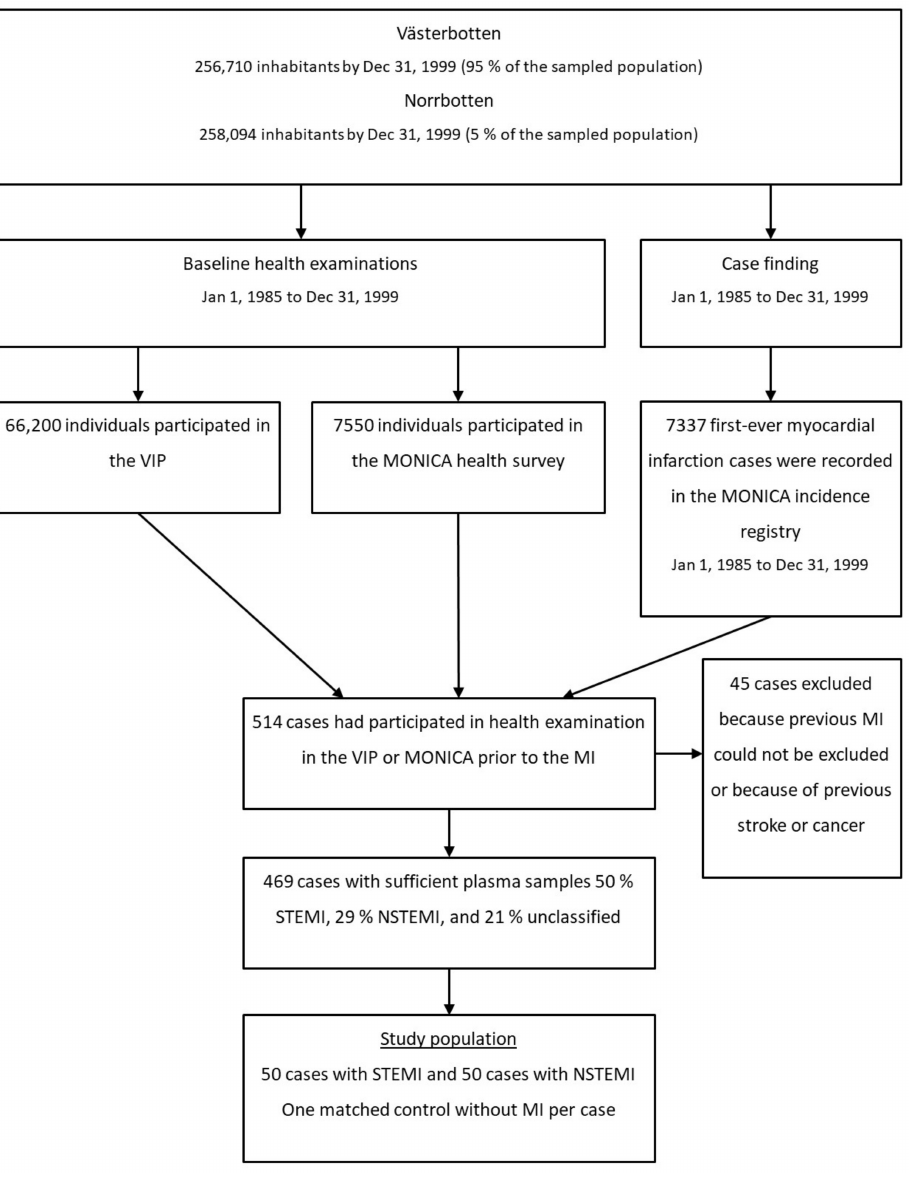
Figure 4. Flow chart of the study